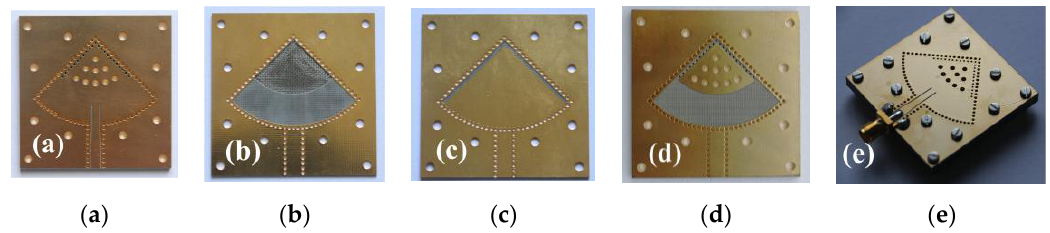
Figure 4. The photographs of the fabricated sensor prototype: ( a ) first layer, ( b ) second layer, ( c ) third layer, ( d ) forth layer, and ( e ) the final assembled sensor.